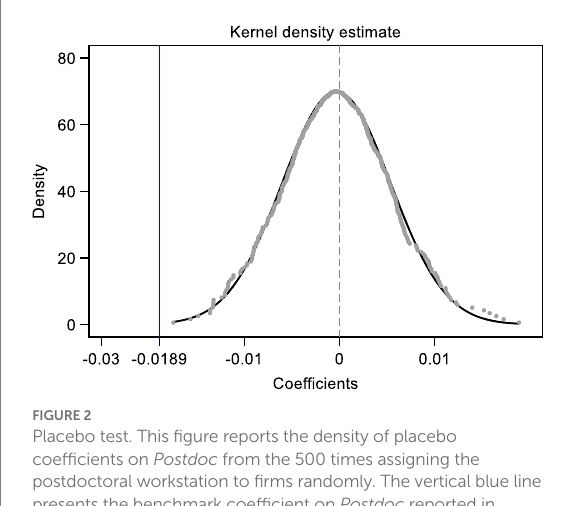
FIGURE 1 Parallel trend. This figure reports the annual dynamics of postdoctoral workstations on labor investment efficiency. Specifically, the figure plots the coefficients on Postdoc and the corresponding 95% confidence interval based on the event study approach.